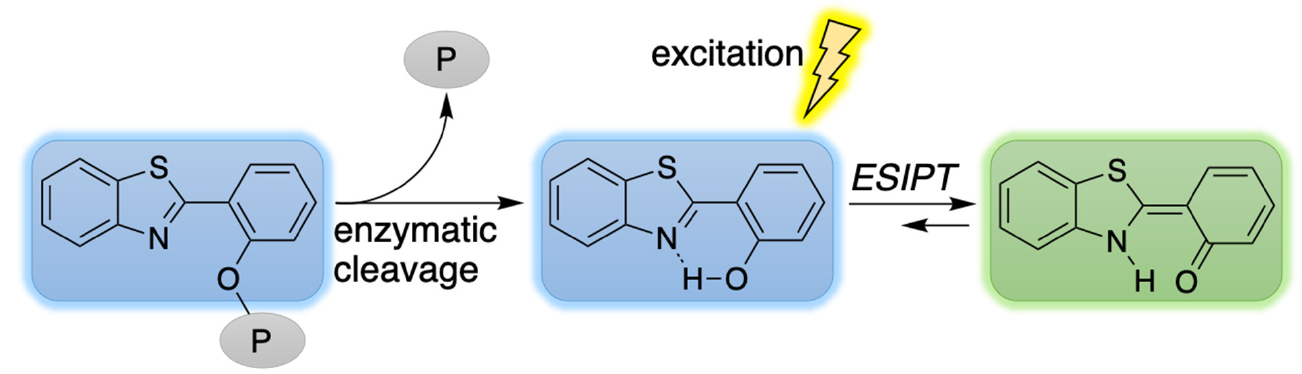
Figure 4. Proposed strategy for immobilizing HBT upon enzymatic